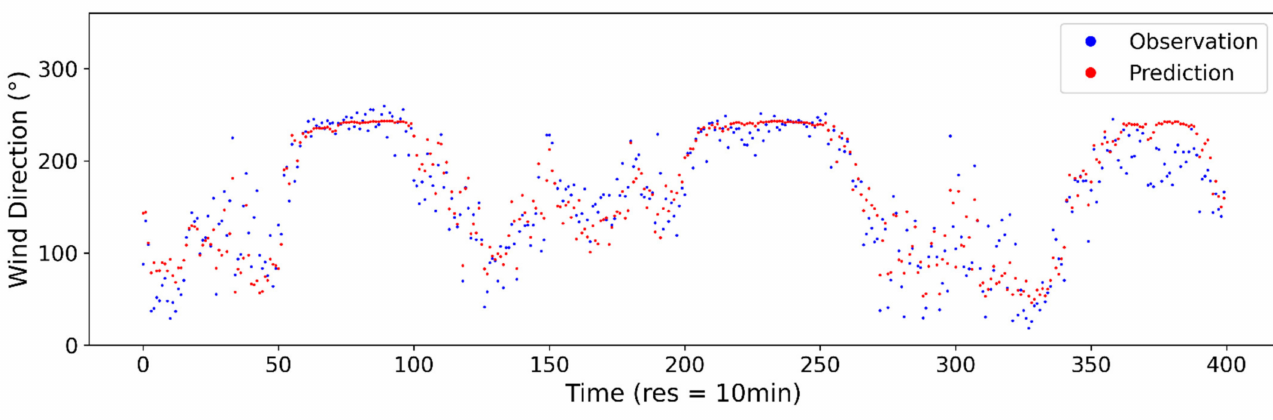
Figure A10. Estimated vs. observed wind direction at 2-min sampling interval using ANN